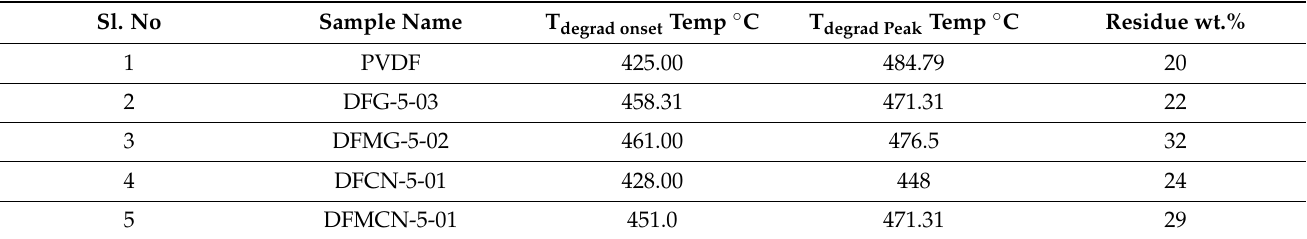
Figure 8. ( a ) TGA graphs and ( b ) DTG graphs of the MWCNT-PVDF nanocomposites. Table 3. Thermal degradation results of the MWCNT/GNF-PVDF nanocomposites.